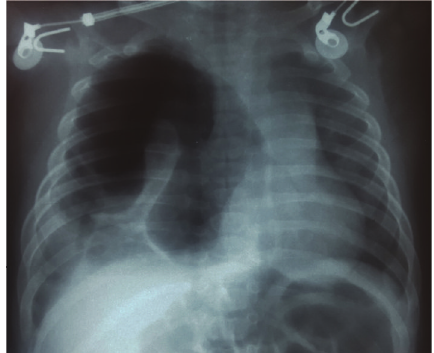
Figure 1: Chest X-ray on